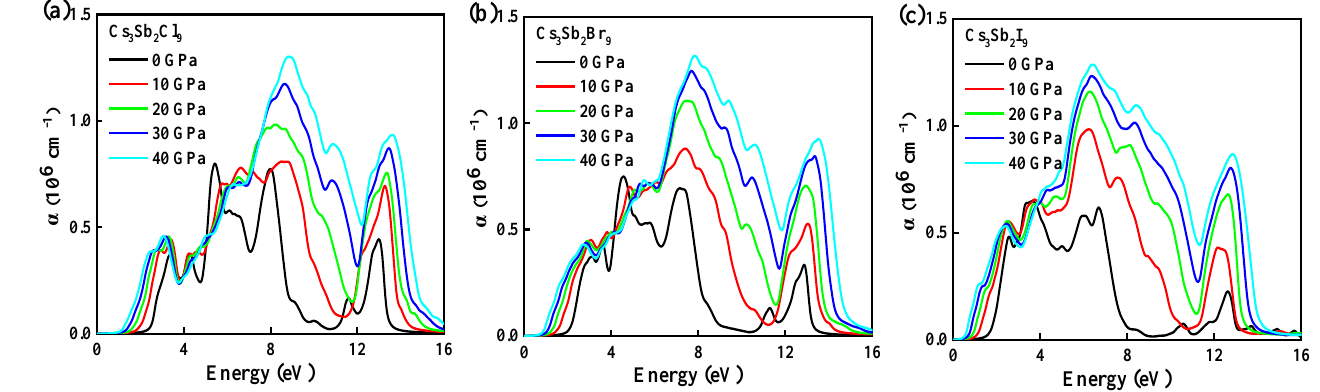
Figure 6. Optical spectra of Cs 3 Sb 2 Cl 9 ( a ); Cs 3 Sb 2 Br 9 ( b ); and Cs 3 Sb 2 I 9 ( c ); as a function of energy are calculated by PBE functional under different pressures.